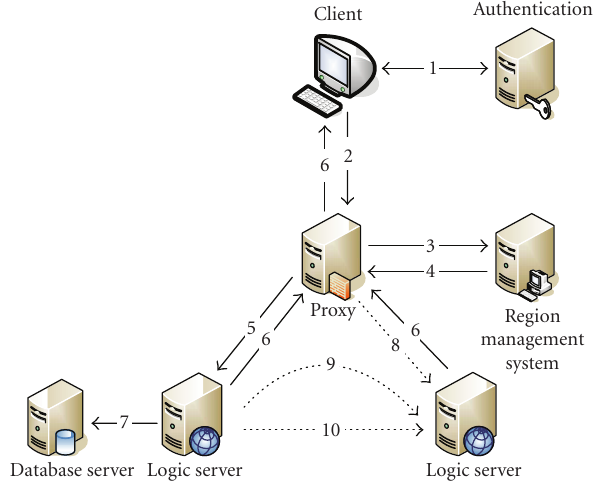
Figure 2: Typical usage scenario of